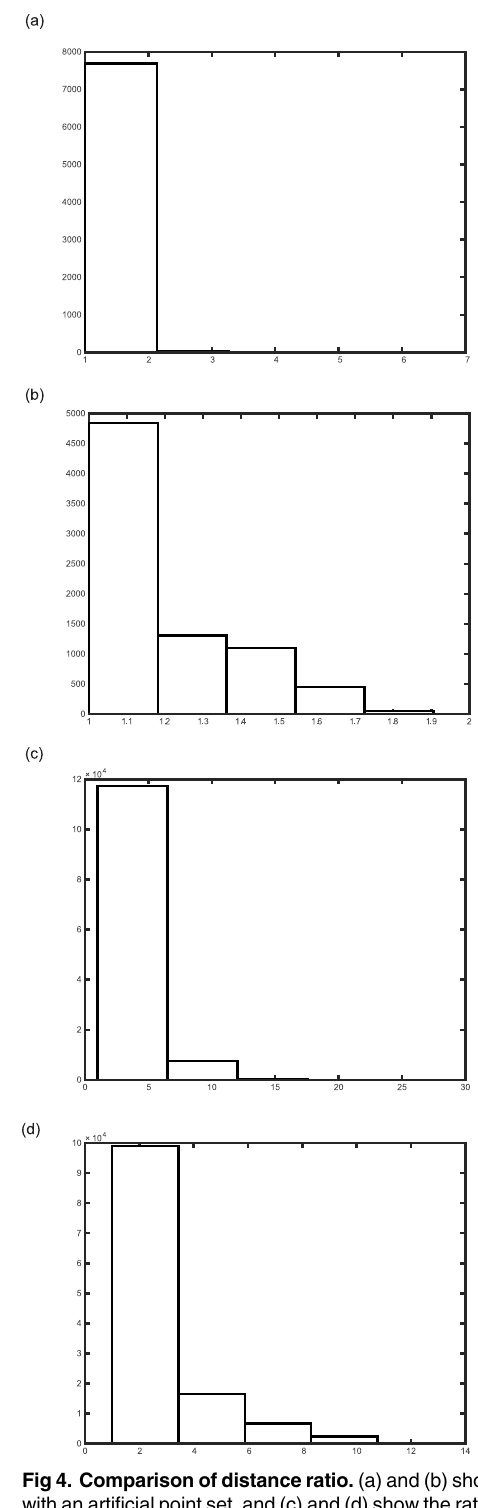
Fig 4. Comparison of distance ratio. (a) and (b) show the ratios for TRN and ITRN, respectively, calculated with an artificial point set, and (c) and (d) show the ratio s for TRN and ITRN, respectively, calculated with a Swiss roll